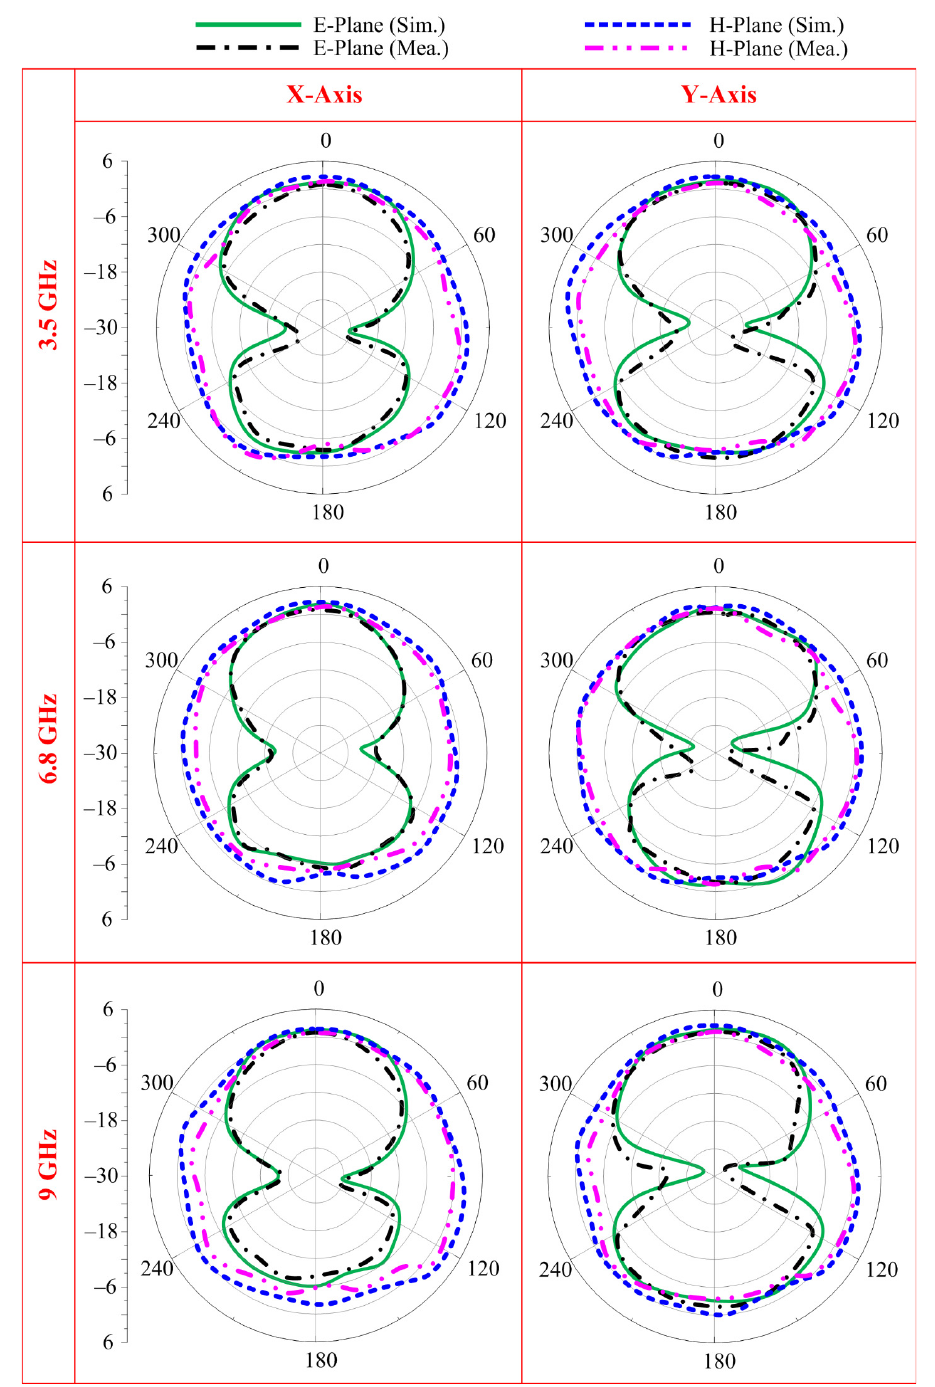
Figure 12. Comparison between predicted and measured radiation patterns of the proposed an- tenna